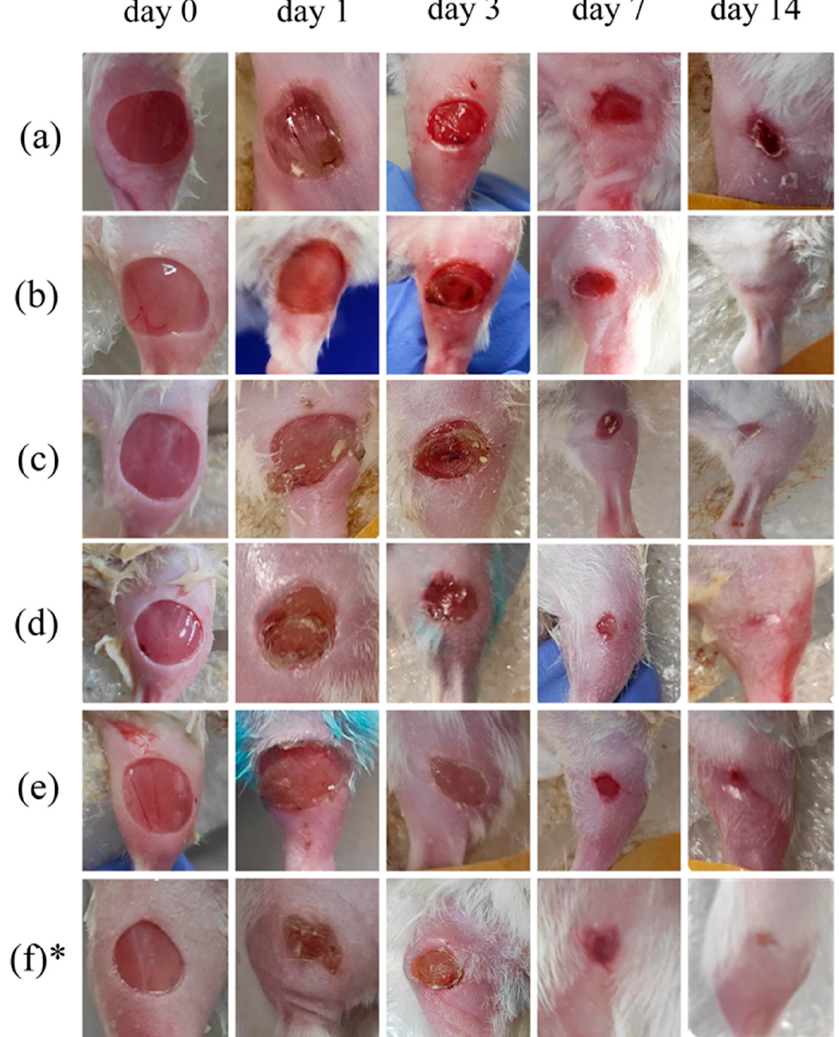
Figure 6. Digital photos of the wound healing progression from day 0 to day 14: ( a ) control group, ( b ) 5-ALA 4 J/cm 2 group, ( c ) 5-ALA 1 J/cm 2 group, ( d ) MB 4 J/cm 2 group, ( e ) MB 1 J/cm 2 group, ( f ) healthy control without diabetes. * This line of pictures was adapted from [6] under CC BY 4.0 license. 2022,